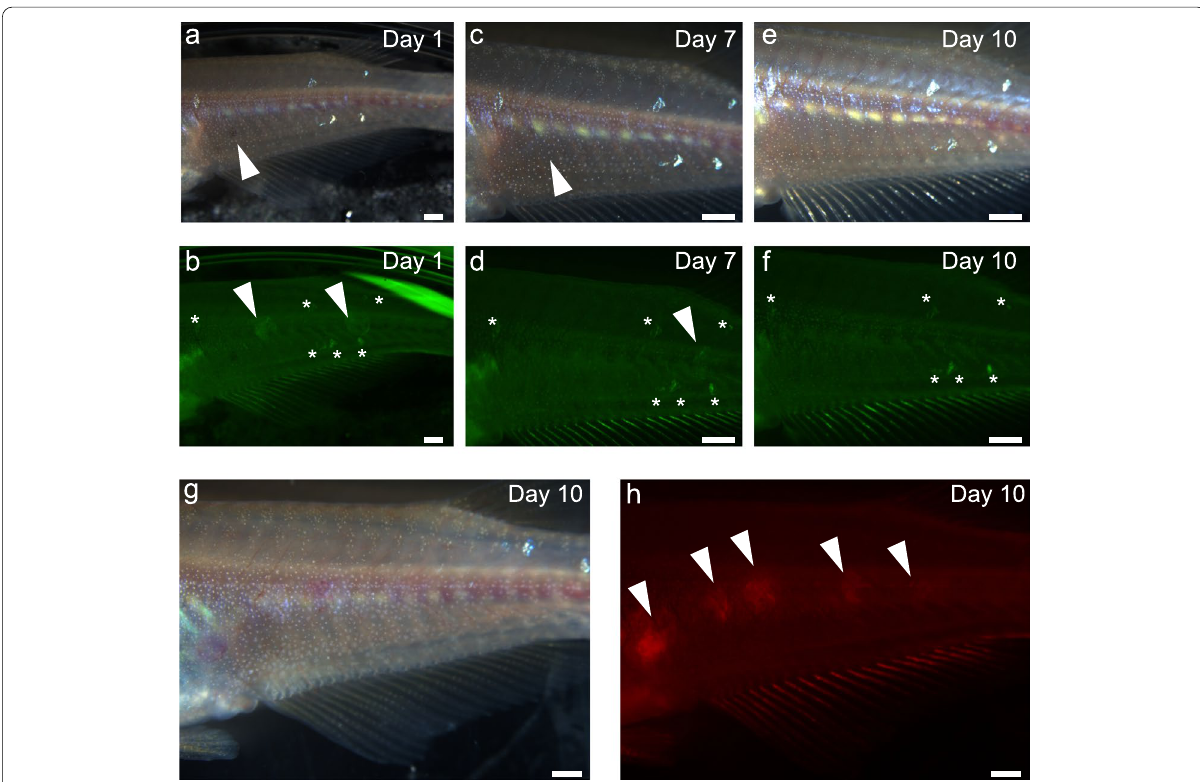
Fig. 3 Allografted scales were immunologically rejected by the recipient. Representative images of transplanted allogenic ( a–f ) or isogenic ( g, h ) scales into a recipient. a, c, e Representative bright field images of scales from a donor ( actb ‑GFP strain and wild‑derived strain) transplanted into